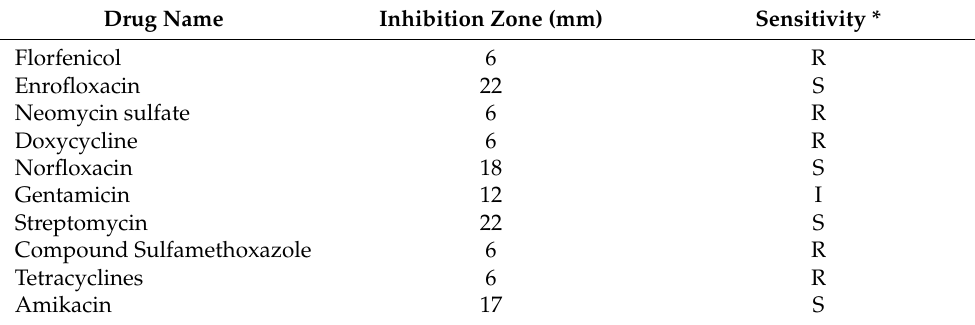
Table 3. Antibiotic susceptibility test results.